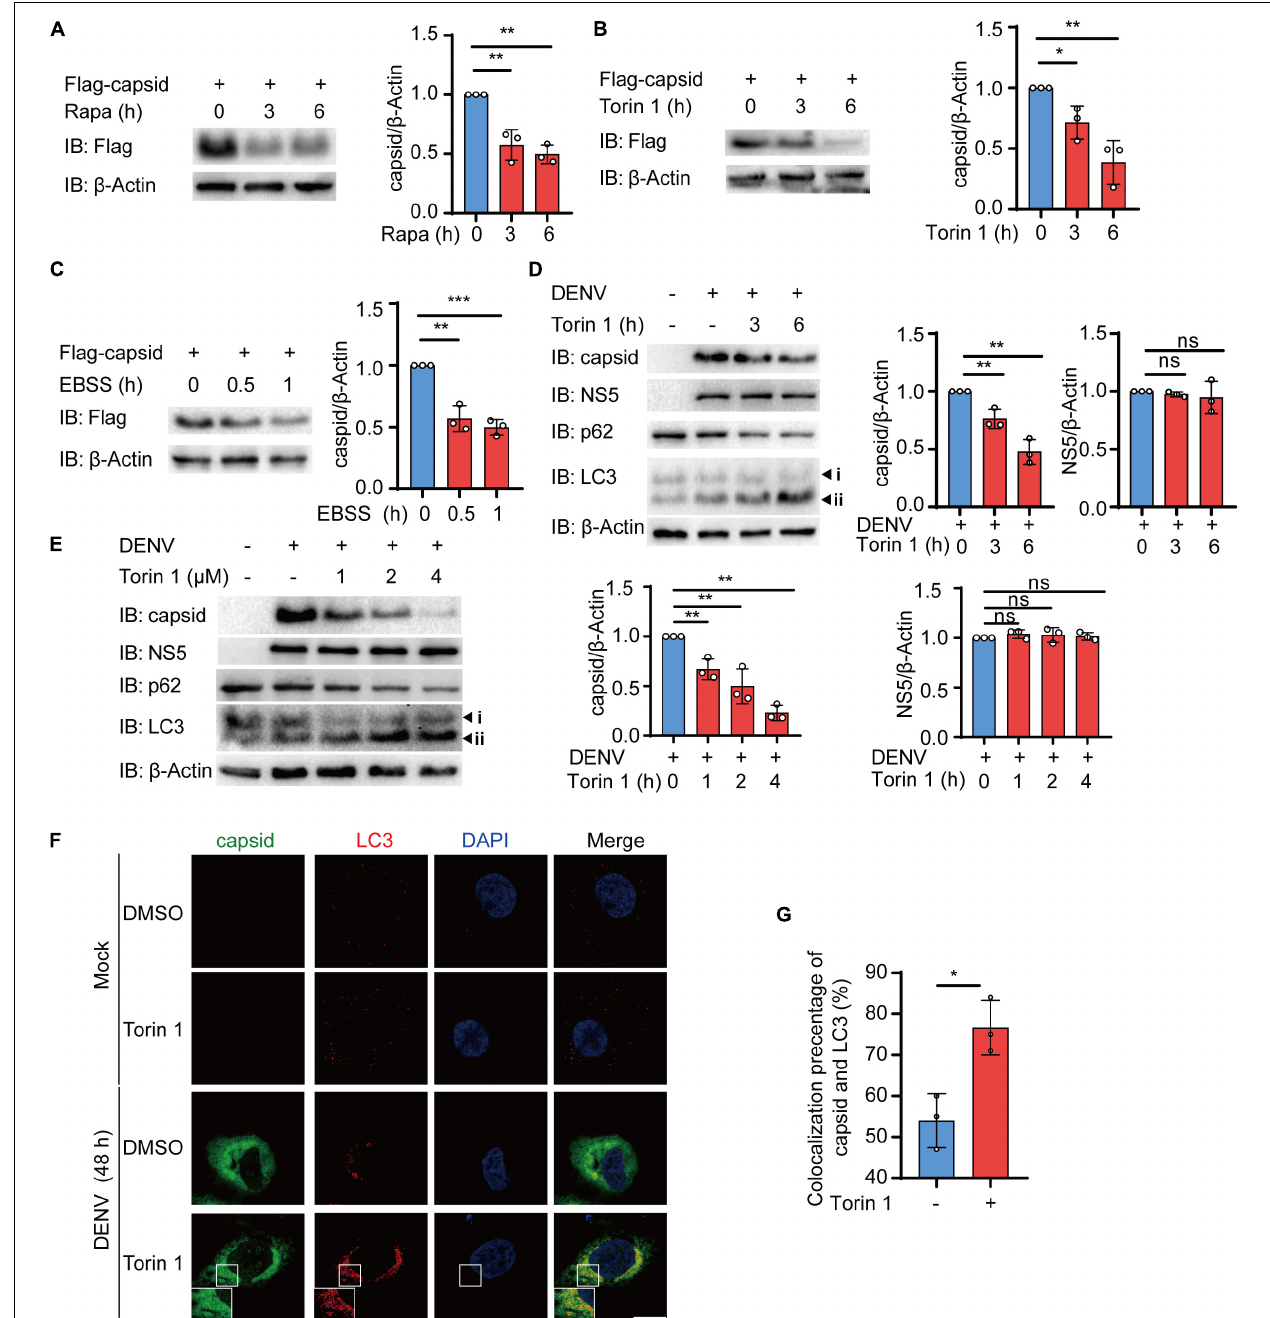
FIGURE 1 | Autophagy reduces the protein abundance of dengue virus (DENV) capsid protein. (A–C) 293T cells that stably expressed C protein were treated with 4 µ M Rapa (A) , 2 µ M Torin 1 (B) , or earle’s balanced salt solution (EBSS) (C) for indicated time points. The cell lysates were subjected to immunoblot analysis, and the quantified levels of C protein were normalized to β -actin. (D) Huh7 cells were infected with DENV (MOI = 0.5), followed by 2 µ M Torin 1 treatments for indicated time points before harvesting. The cell lysates were immunoblotted with indicated antibodies, and the quantified levels of C protein were normalized to β -actin. (E) Huh7 cells were infected with DENV (MOI = 0.5), followed by indicated doses of Torin 1 treatments for 6 h before harvesting. The cell lysates were immunoblotted with indicated antibodies, and the quantified levels of C protein (left) or NS5 (right) were normalized to β -Actin. (F) Confocal microscopy of Huh7 cells infected with DENV (MOI = 0.5) for 24 h and treated with Torin 1 (2 µ M) for 6 h, followed by labeling of C protein and LC3 with specific primary antibody and a CF568 goat anti-mouse IgG secondary antibody (red) and Alexa Fluor 488 conjugated anti-rabbit-IgG secondary antibody (green). Scale bar, 10 µ m. (G) Pearson’s correlation coefficients of DENV C protein and LC3 in (F) . Data represent replicate measurements in at least 10 cells for one independent experiment, and these experiments have been replicated three times. Data in (A–E,G) are expressed as mean ± SEM of three independent experiments. * p < 0.05, ** p < 0.01, NS, not significant (two-tailed Student’s t -test). All the experiments are representatives of three independent biological experiments with similar results.